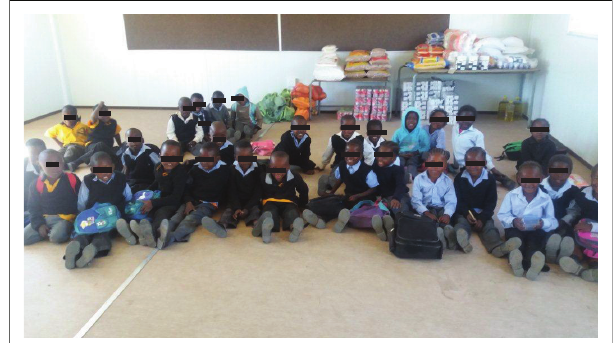
FIGURE 3: Mavhina Primary School in Vuwani after burning. At the back are mobile temporary classrooms provided by the government.